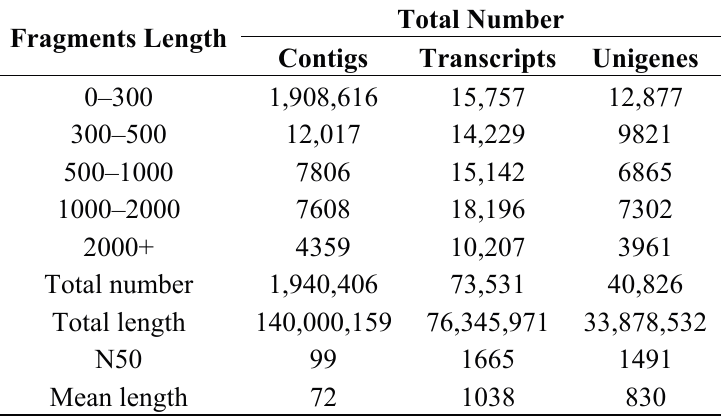
Table 1. Summary of de novo sequence